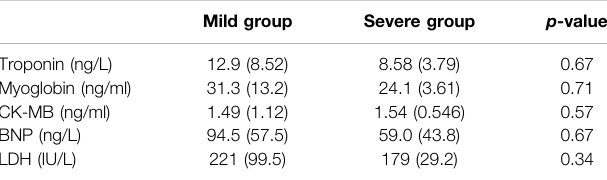
TABLE 5 | Comparison of the baseline levels of serum myocardial enzymes and LDH between different groups.